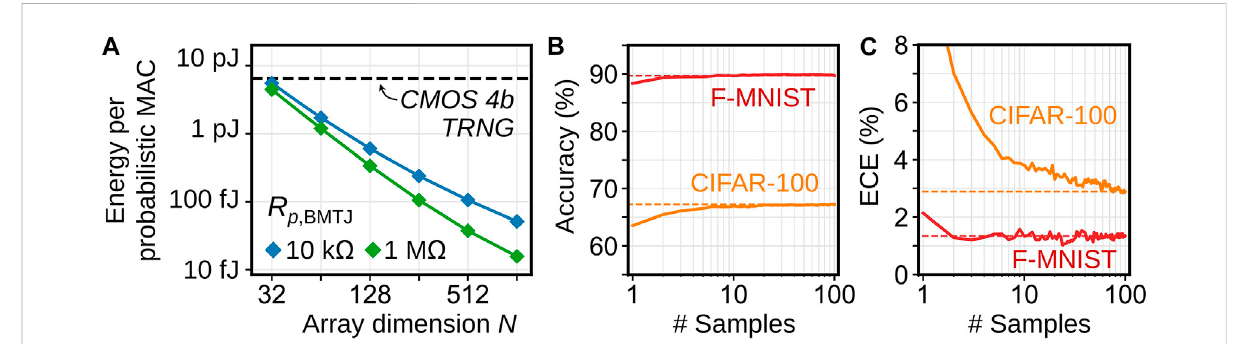
FIGURE 8 (A) Energy consumption per probabilistic MAC operation within an N × N probabilistic MVM executed by the spintronic in-memory computing accelerator (blue). Two values of the Bayes-MTJ parallel resistance are considered. The black dashed line shows the ef fi ciency of performing the same probabilistic MACs using the CMOS True RNG from Bae et al. (2017). (B,C) Accuracy and ECE vs. number of sampled predictions from the spintronic BNN on the Fashion MNIST and CIFAR-100